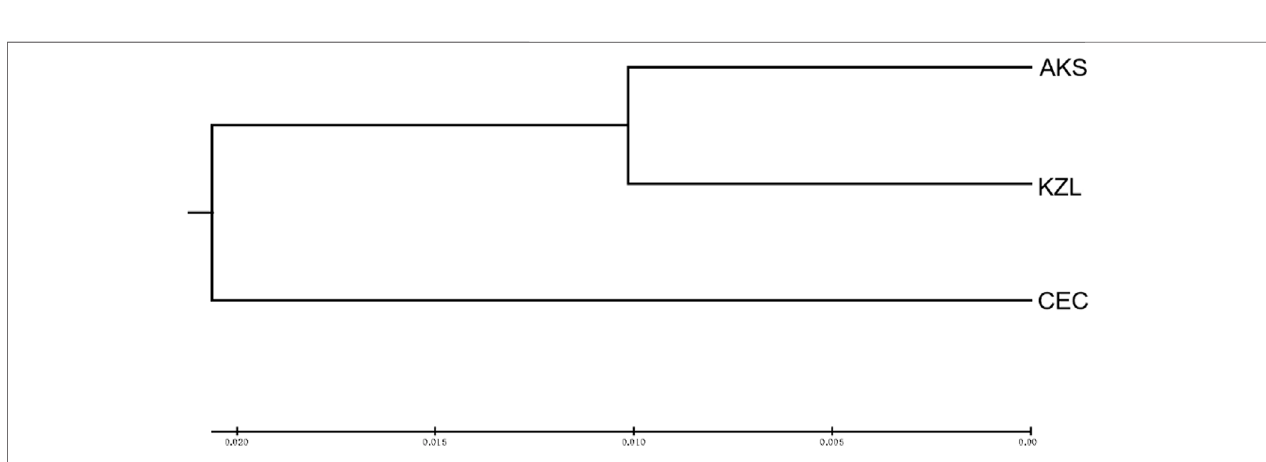
FIGURE 3 | UPGMA clustering tree of 126 samples of Schizothorax biddulphi . I: all individuals of the Aksu and Kyzyl rivers; II: all individuals of the Qarqan River.